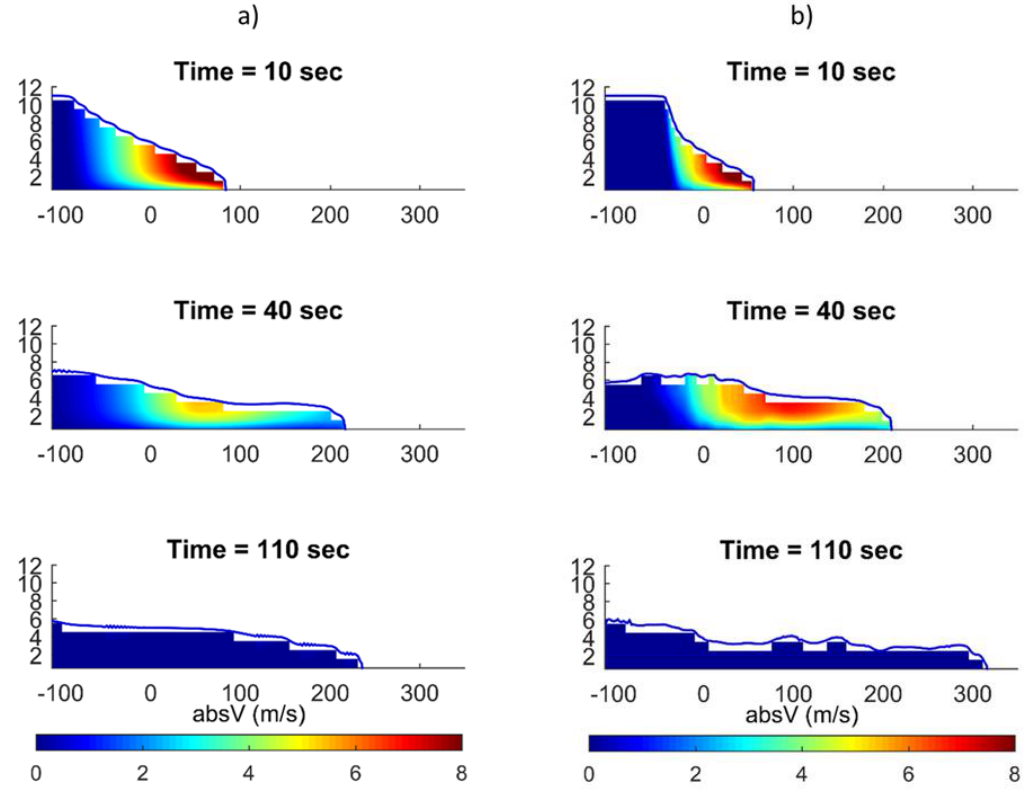
Figure 11. Snapshots of velocity magnitude on the centerline cross-section of the breach (y = 220 m) ( a ) Bingham model (BM); ( b ) modified bi-viscosity model (MBM).